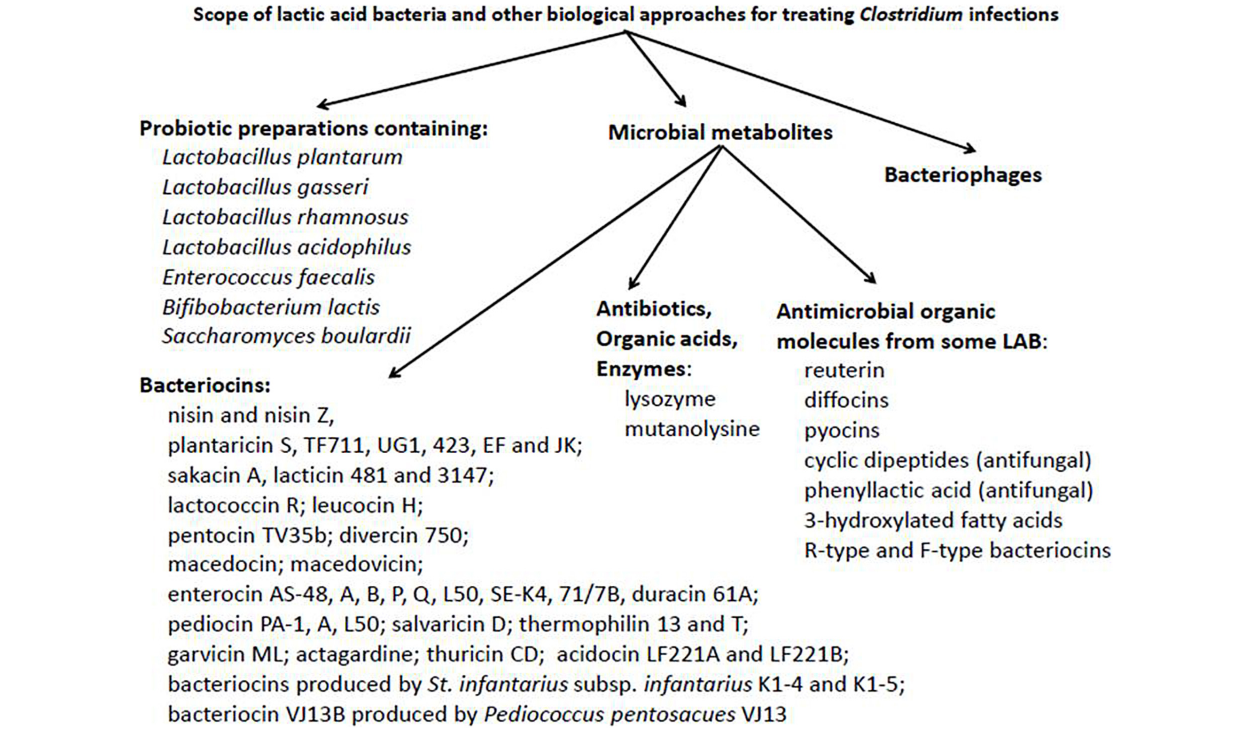
FIGURE 1 | Potential scope of lactic acid bacteria and other non-conventional biological approaches for the treatment of Clostridium